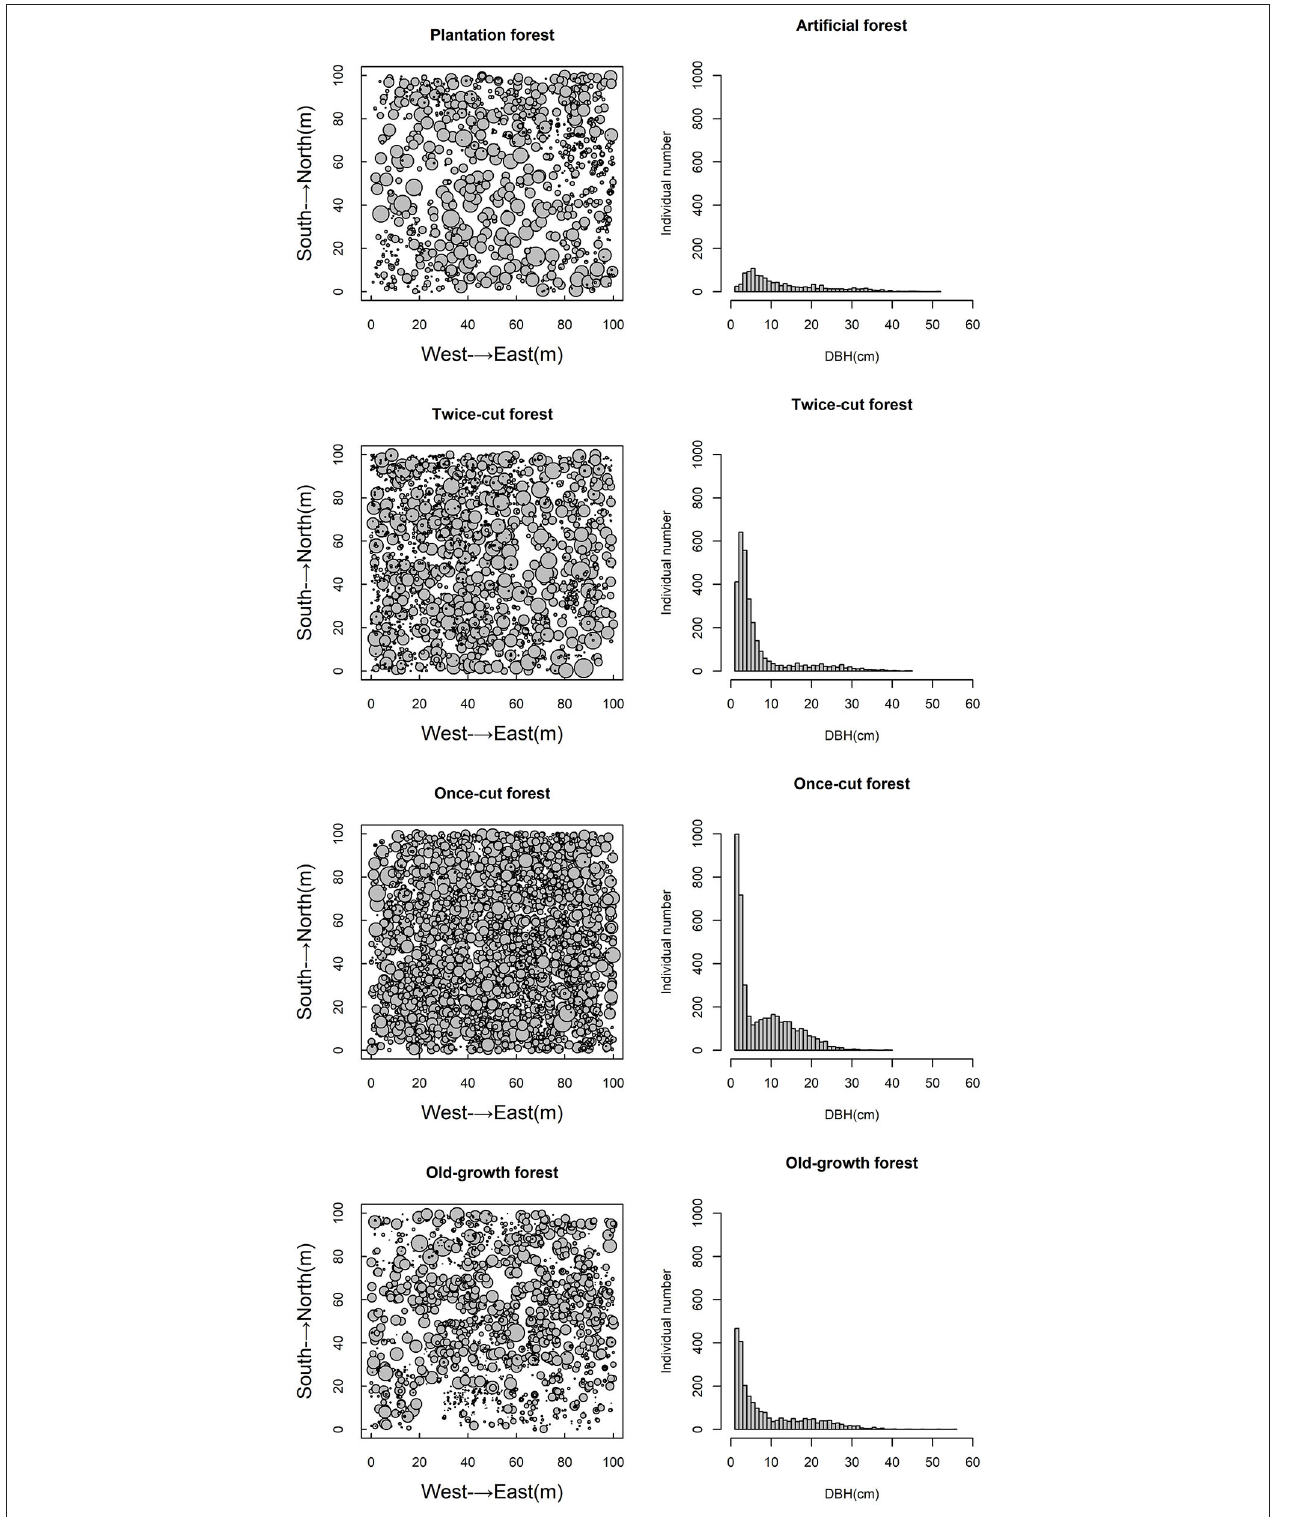
FIGURE 2 | Spatial scatter plots and DBH plots of woody plants in different communities.